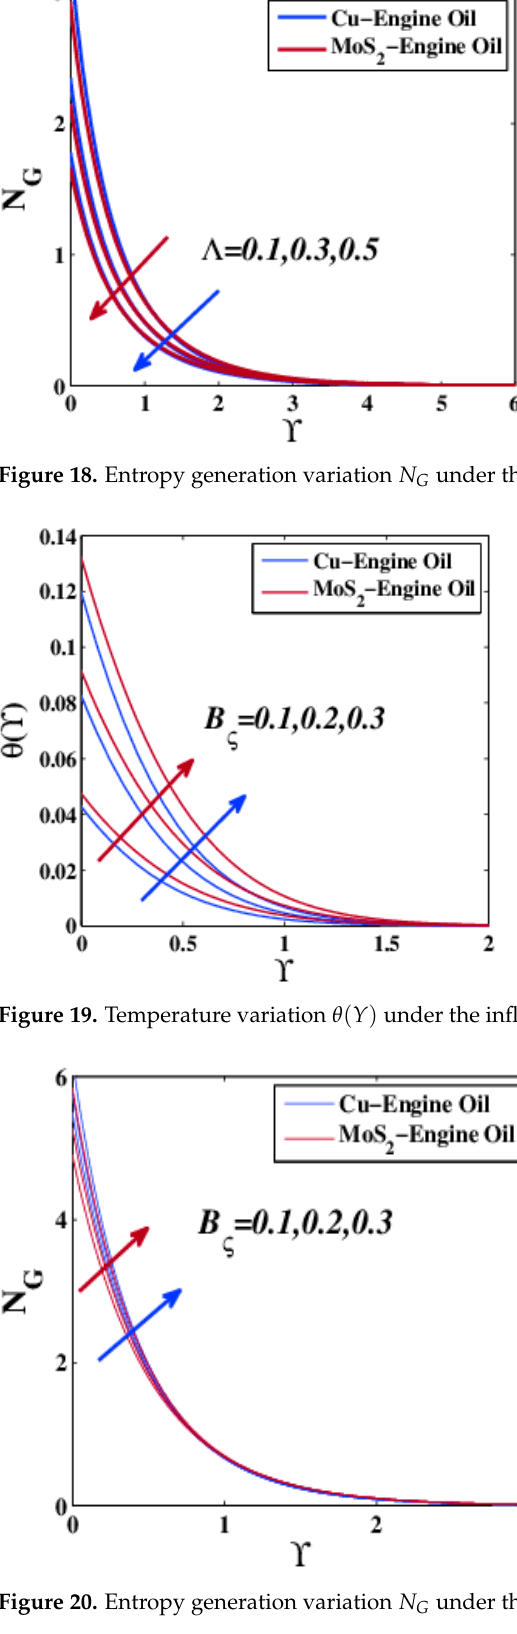
Figure 17. Temperature variation 𝜃(𝛶) under the influence of 𝛬 .